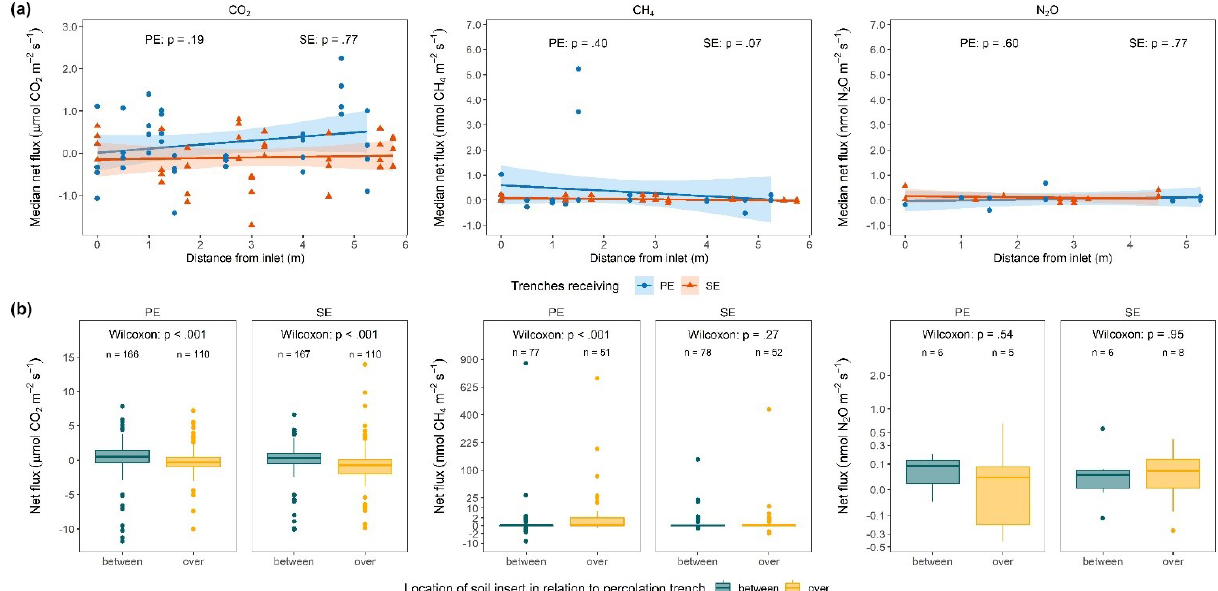
Figure 3. (a) Quarterly median fluxes observed by discrete GHG measurements over the STU as a function of distance from the inlet for trenches receiving PE (blue circles) and SE (red pyramids). Linear fits are marked by solid lines. The shaded areas represent the standard error of the fit. (b) Boxplots comparing net fluxes observed by discrete GHG measurements over the STU from soil inserts located either between (blue) or over (red) gravel trenches. Statistical results are presented as the p value of Wilcoxon signed rank tests; n denotes the number of observations per group. Note that in both subfigures the y scale for CO 2 is given in units different from units used for CH 4 and N 2 O and that the y axis for CH 4 and N 2 O has been square-root transformed in panel (b) to improve data